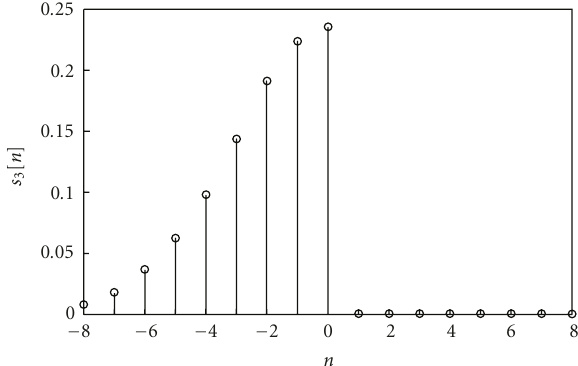
Figure 3: Example of directional spreading